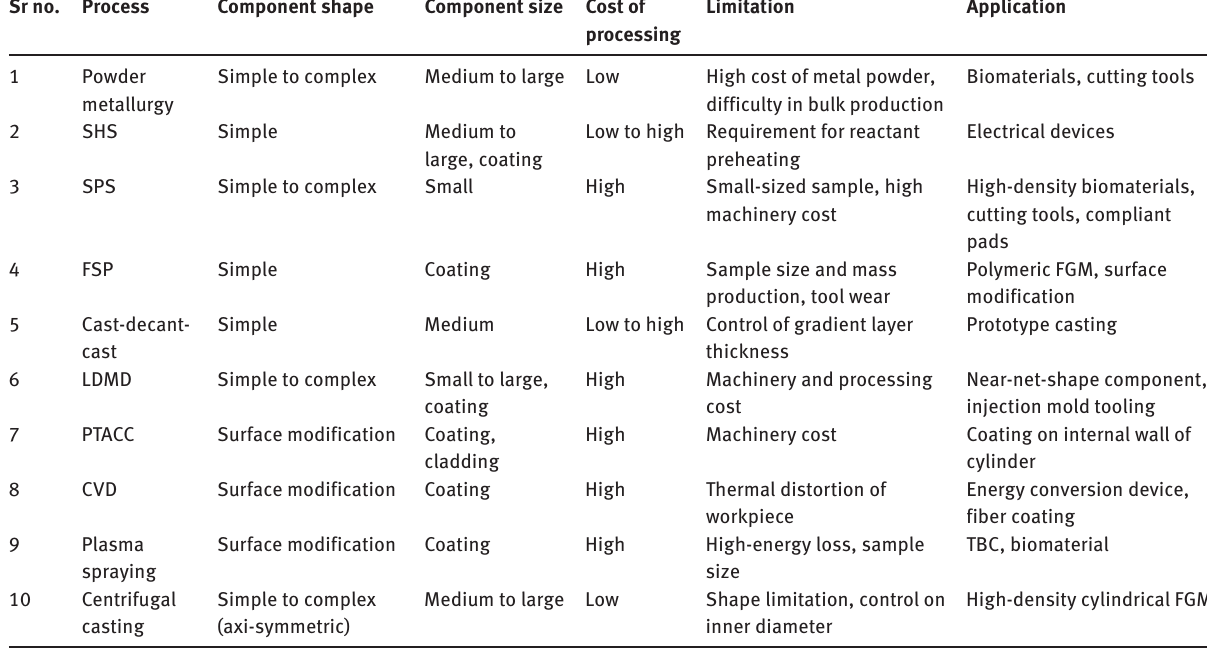
Table 9: Overview of the FGM processing method. Sr no.